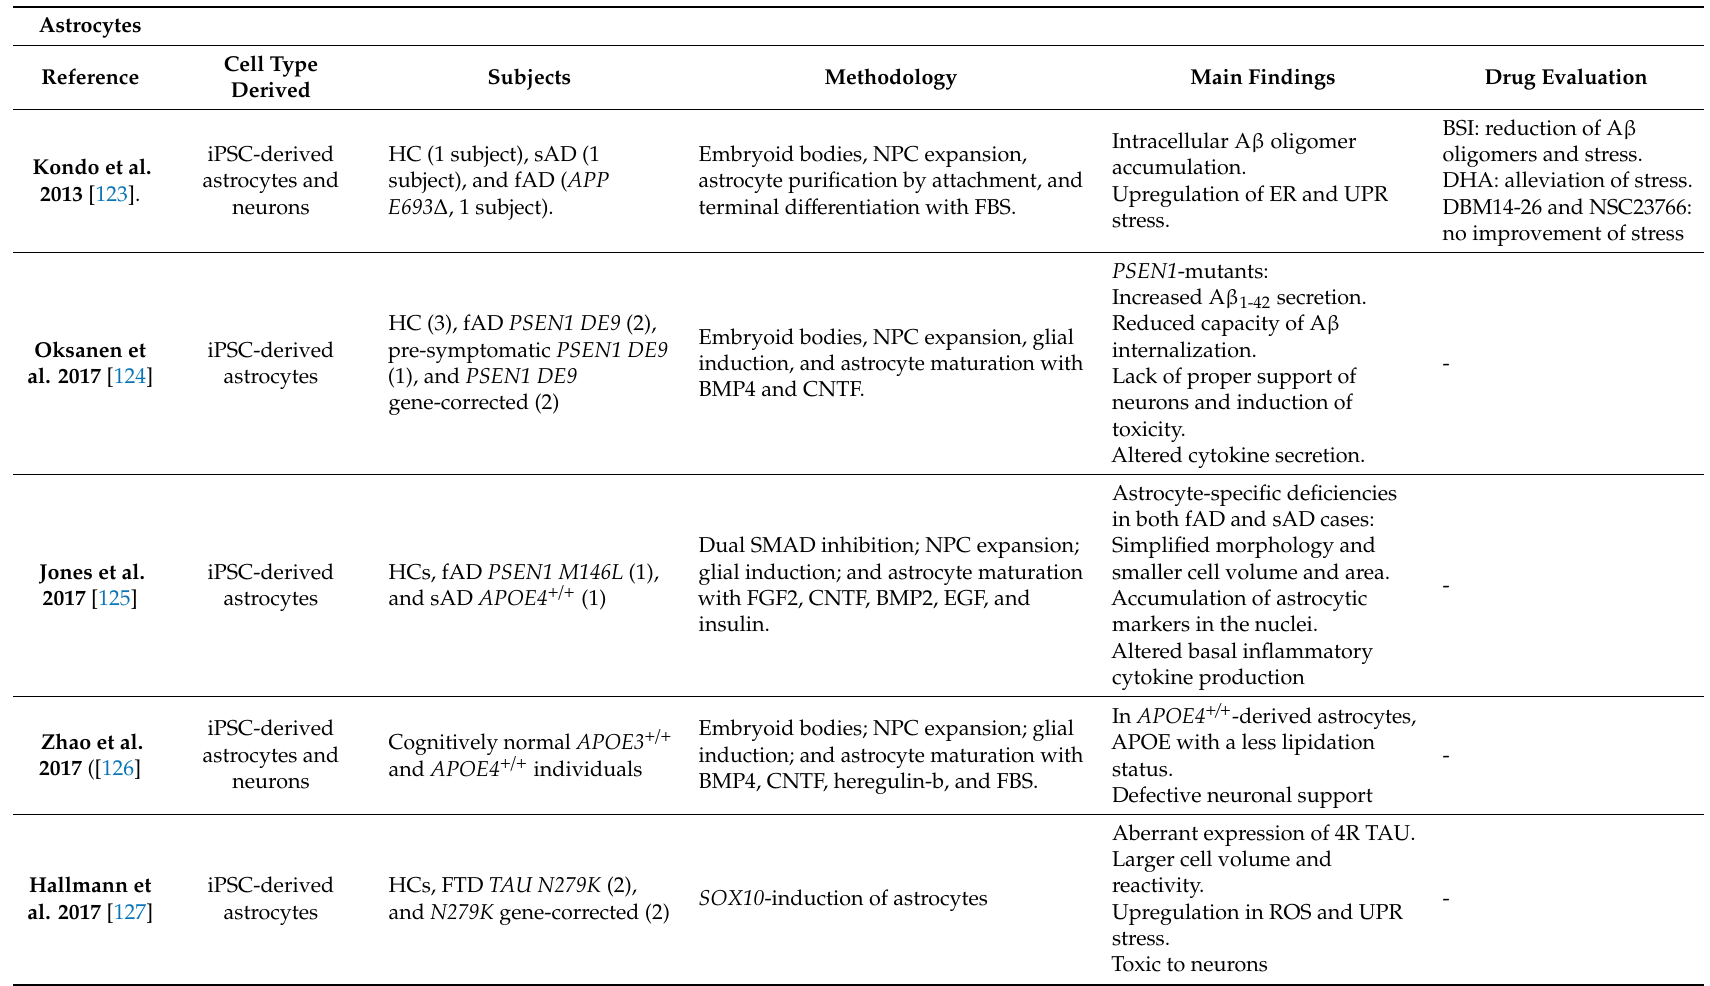
Table 2. Summary of the findings of the main studies describing the generation of hPSC-derived astrocytes from patients with Alzheimer’s